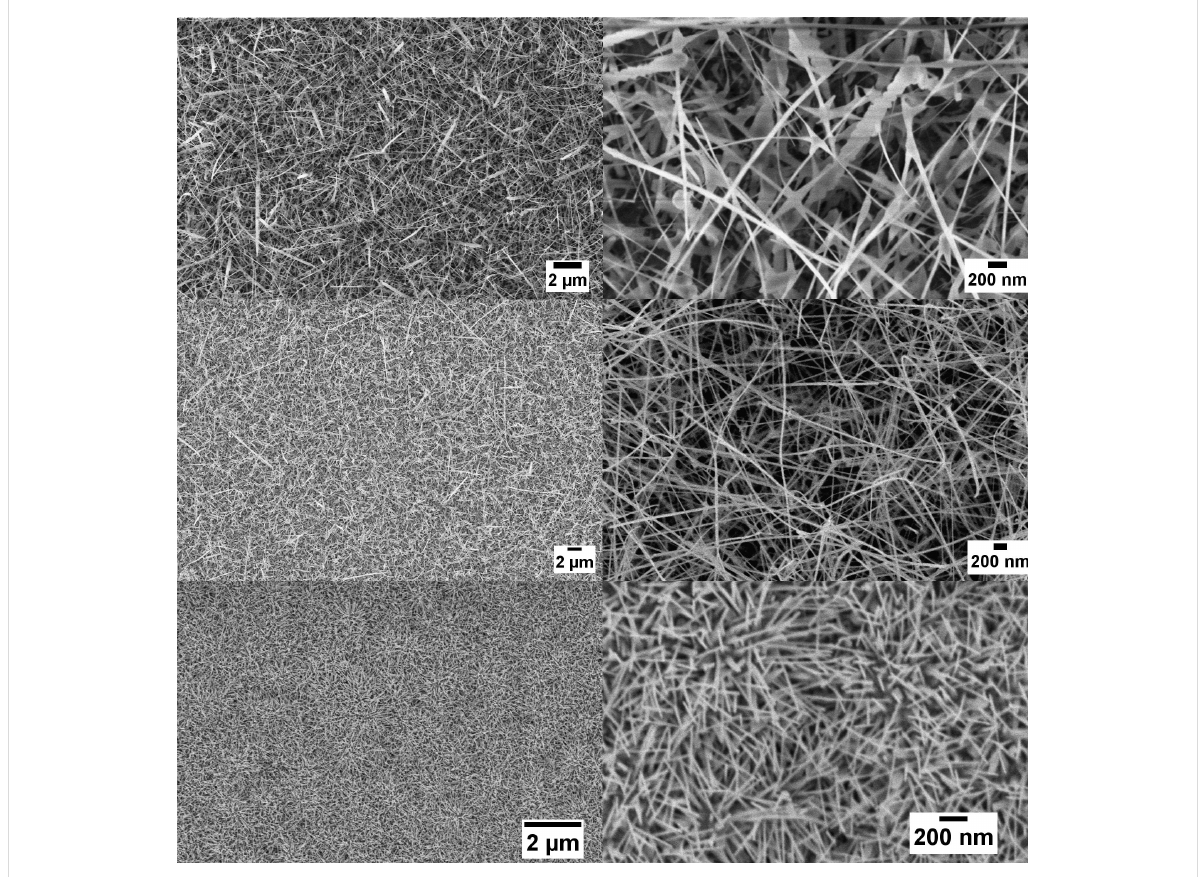
Figure 1: FE-SEM images of NiO nanowires at different magnifications (top), SnO 2 nanowires (middle) and ZnO nanowires